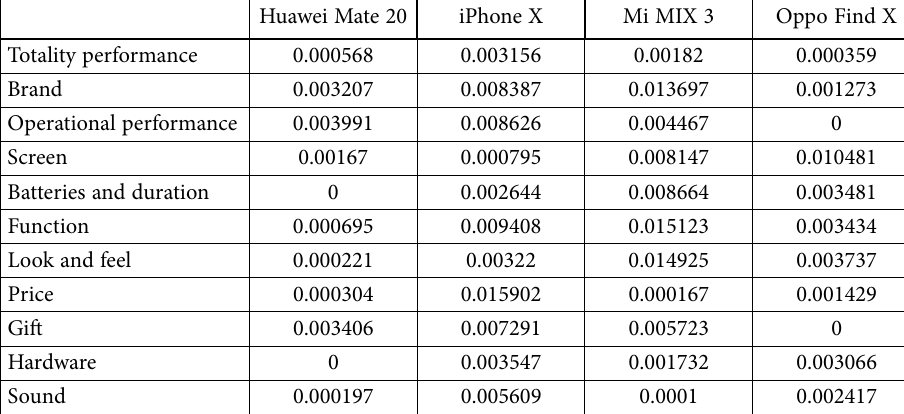
Table 16. The relative